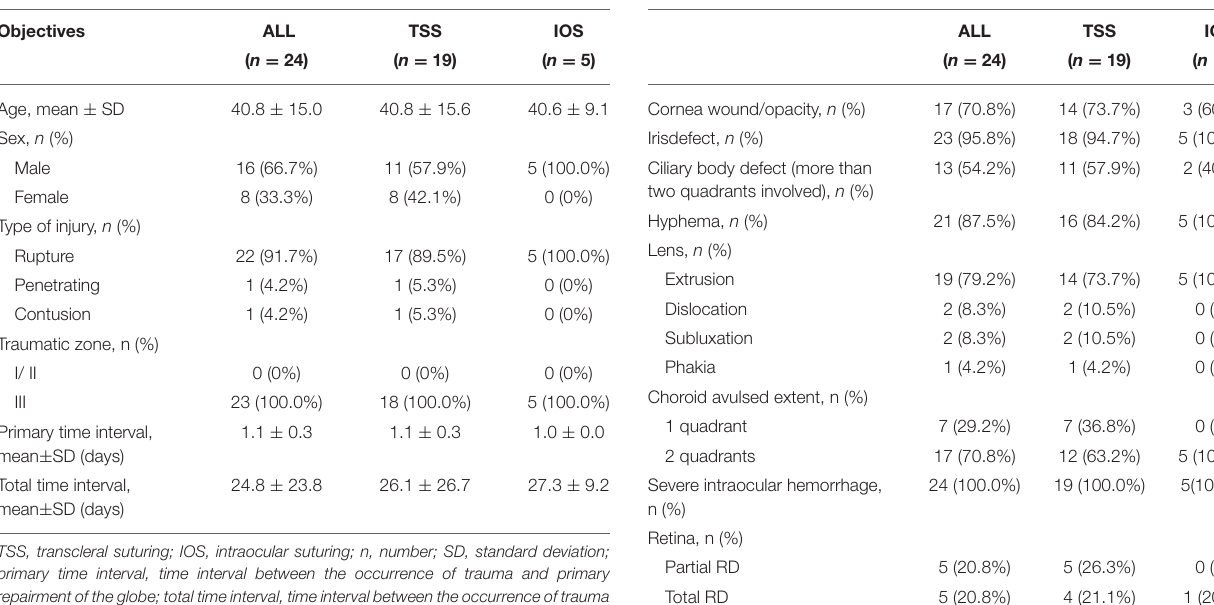
TABLE 2 | Ocular characteristics and surgical